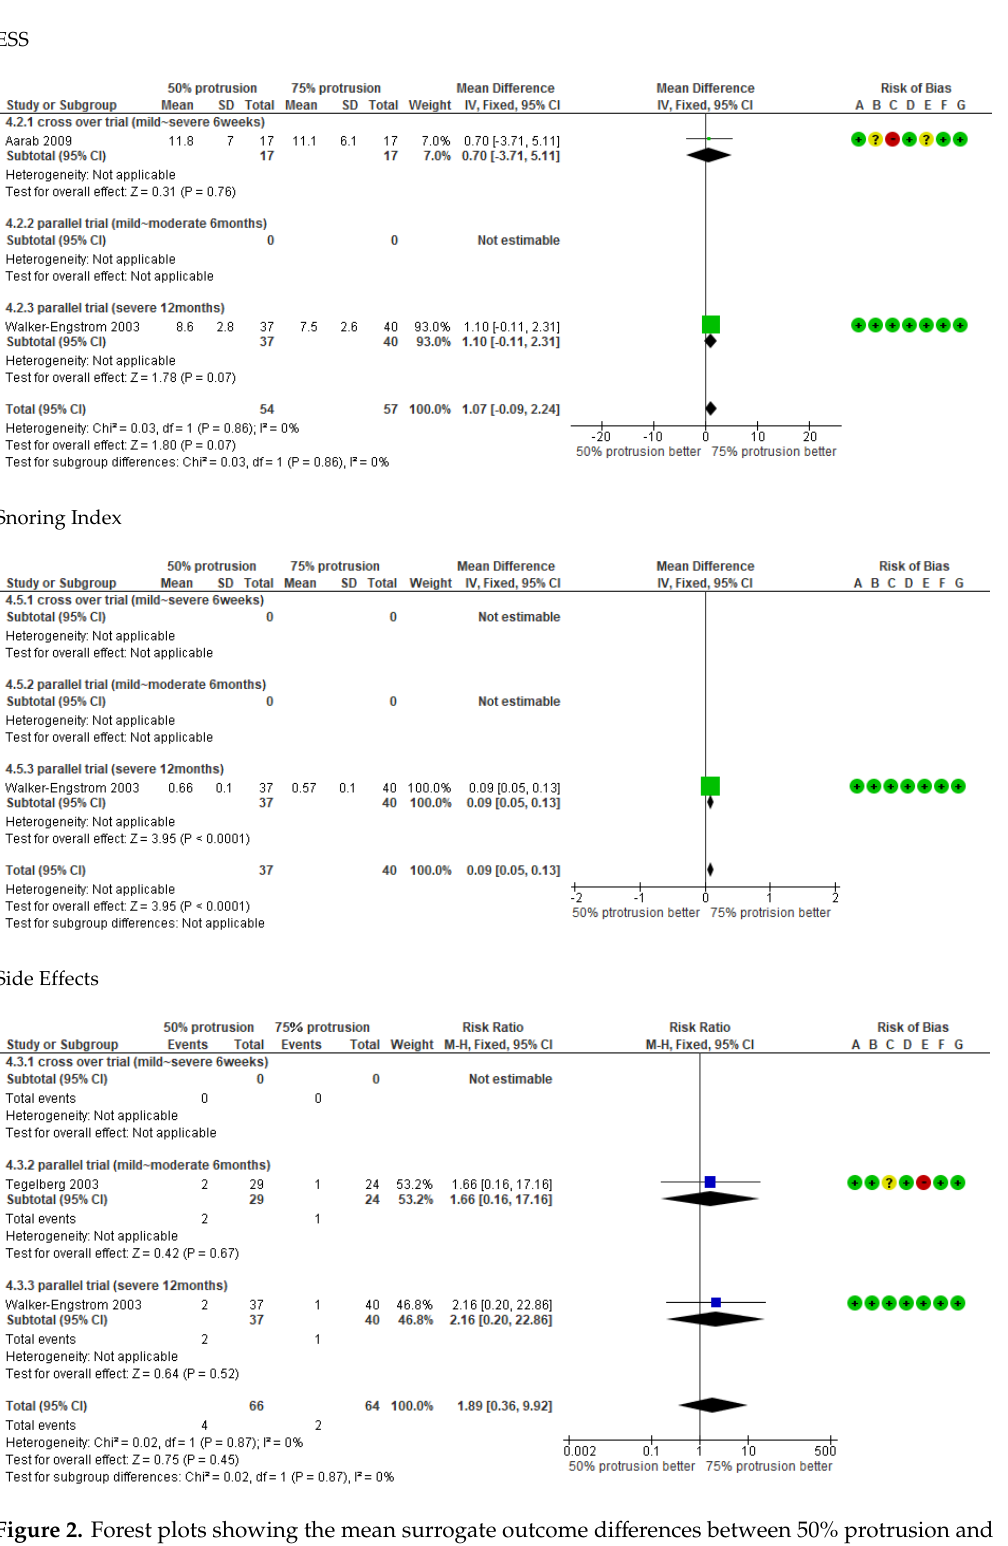
Figure 2. Forest plots showing the mean surrogate outcome differences between 50% protrusion and 75% protrusion in the included studies. The horizontal axis of the forest plot in Sleep Stage 3 is reversed (75%, and 50% protrusion better). Risk of bias legend: (A) Random sequence generation (selection bias), (B) Allocation concealment (selection bias), (C) Blinding of participants and personnel (performance bias), (D) Blinding of outcome assessment (detection bias), (E) Incomplete outcome data (attrition bias), (F) Selective reporting (reporting bias), and (G) Other